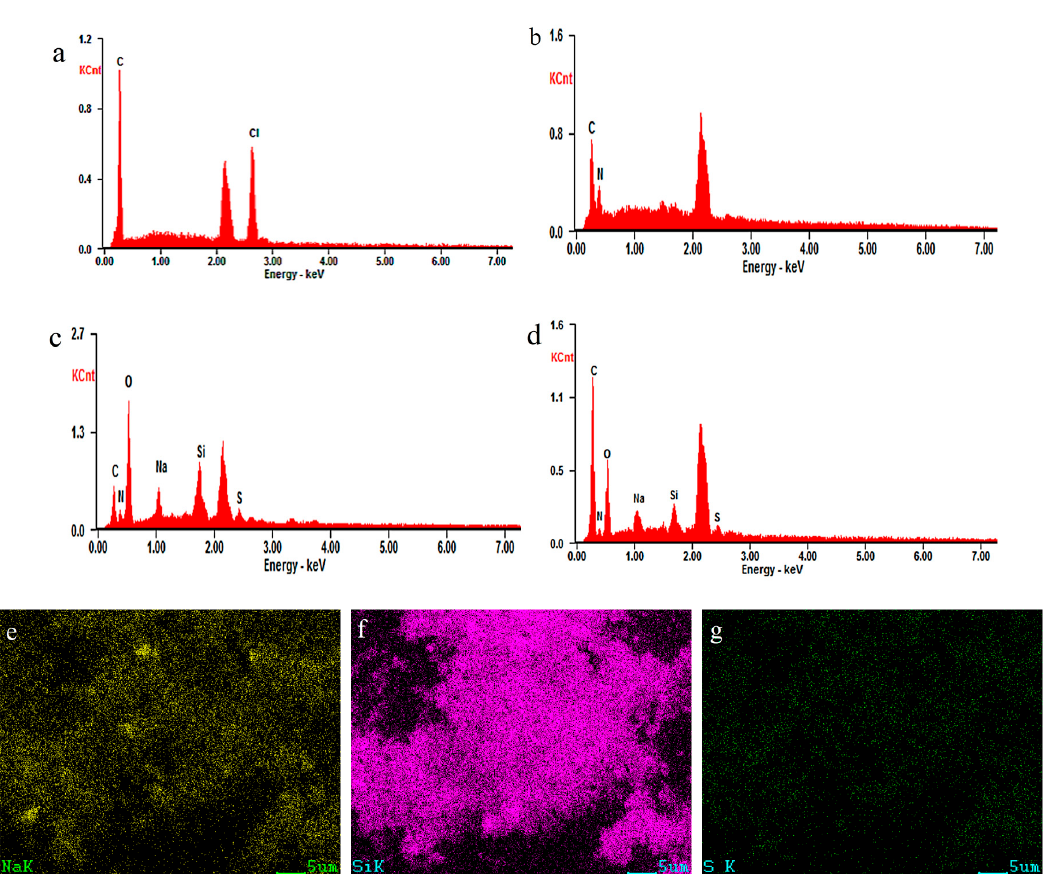
Figure 3. SEM images of the microsphere surface of chloromethyl polystyrene (CPS) ( a , b ) and SLPS ( c , d ).